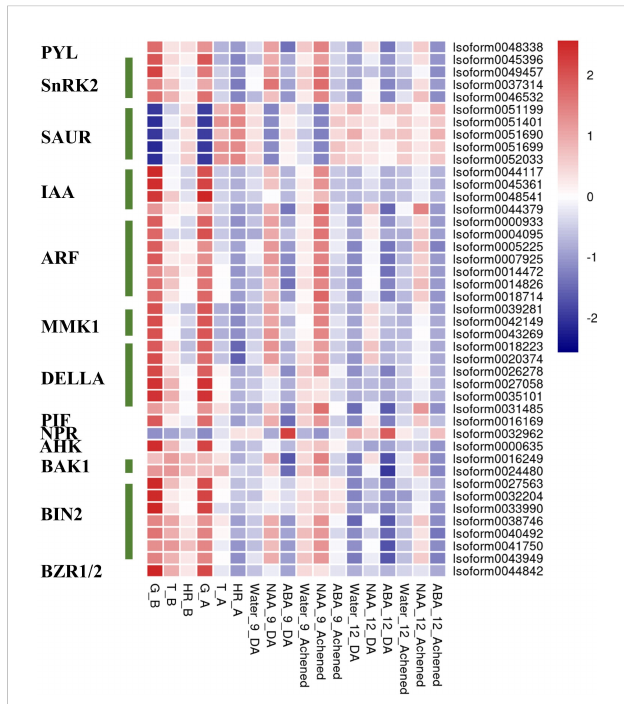
FIGURE 5 The expression pro fi les of hub phytohormone signaling genes in the receptacle during development and under treatments. The expression pro fi les of hub phytohormone signaling genes in the receptacle using heatmap